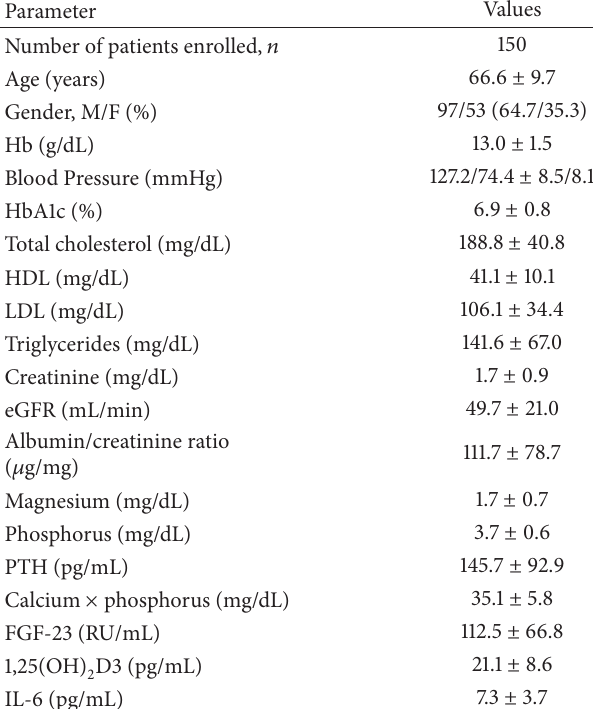
Table 2: Patients’ baseline